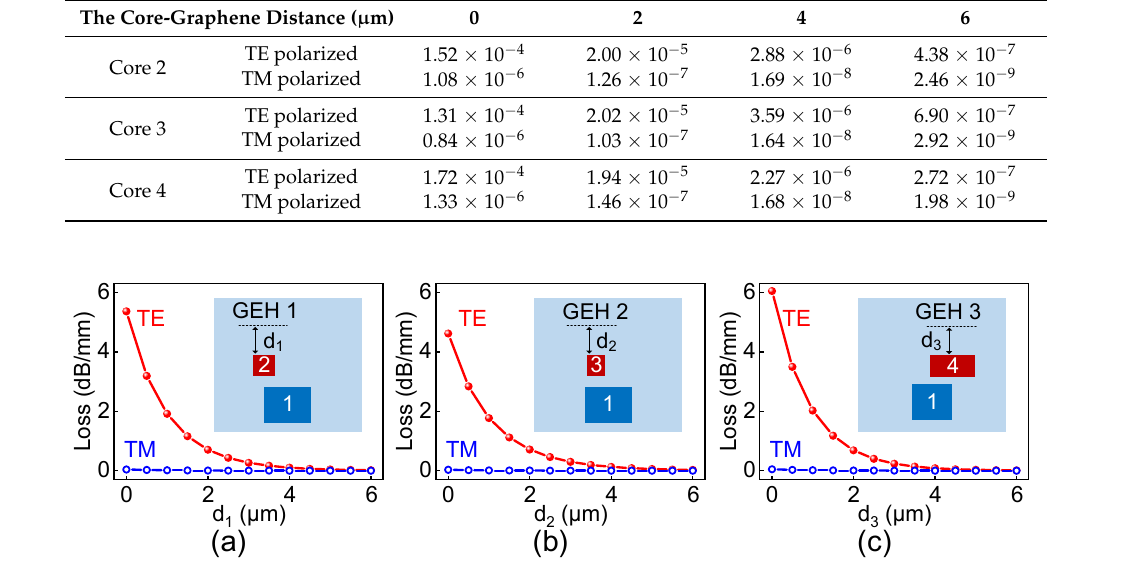
Figure 5. The variation of the graphene-induced absorption losses to the TE and TM polarized light for ( a ) Core 2, ( b ) Core 3, and ( c ) Core 4 with the different core-graphene distances.